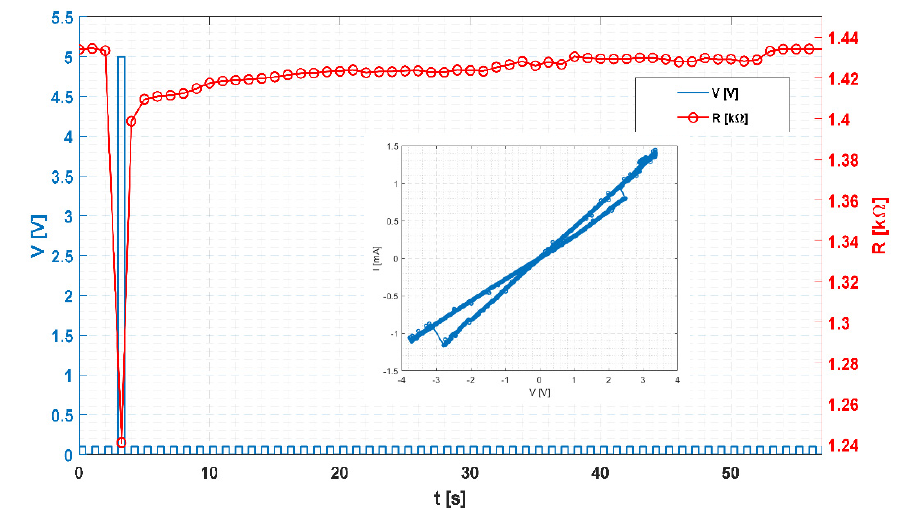
Figure 5. Volatility test of BTO memristor: reading pulses with low amplitude combined with single writing pulse. Inset- current-voltage characteristics of perovskite